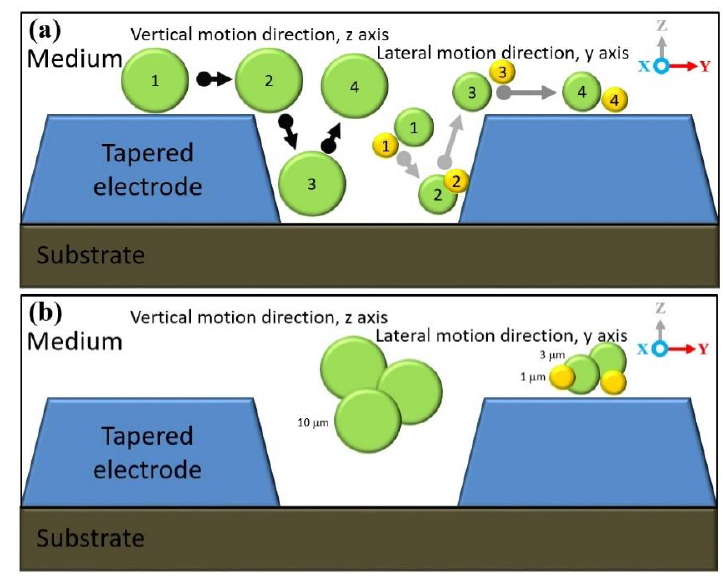
Figure 15. The side view separation sequence: ( a ) The separation steps of Ps 1 µ m, 3 µ m and 10 µ m and ( b ) the separation at two different locations, Ps 1 and 3 µ m, at the top surface and 10 µ m between two tapered DEP microelectrodes.